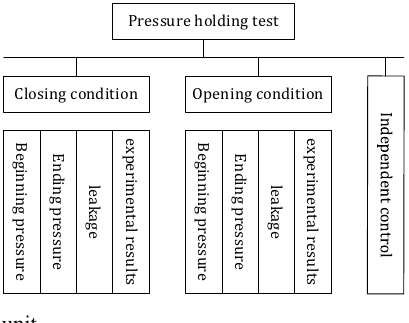
Fig. 2. Pressure holding test